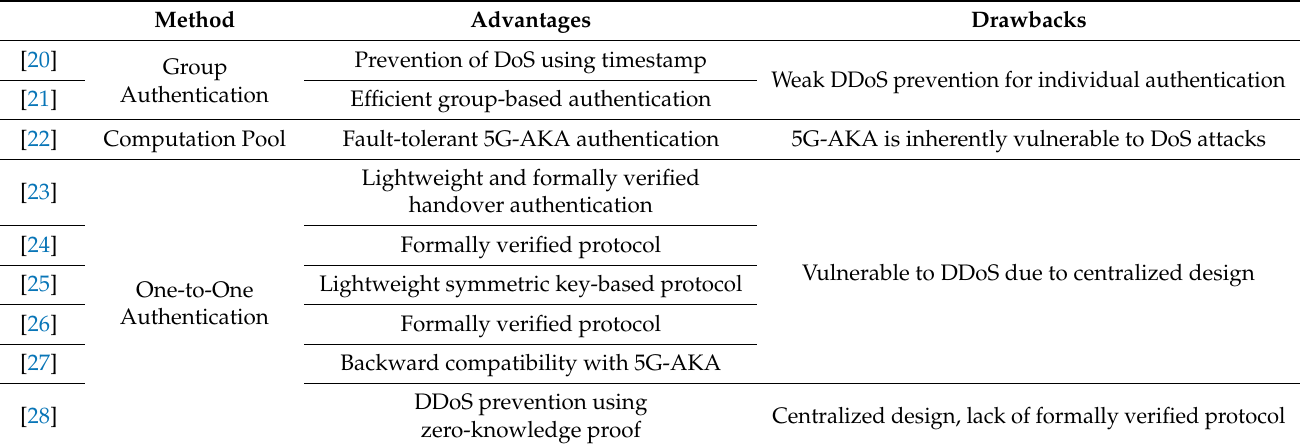
Table 2. Recent works of AKA schemes with DoS and DDoS